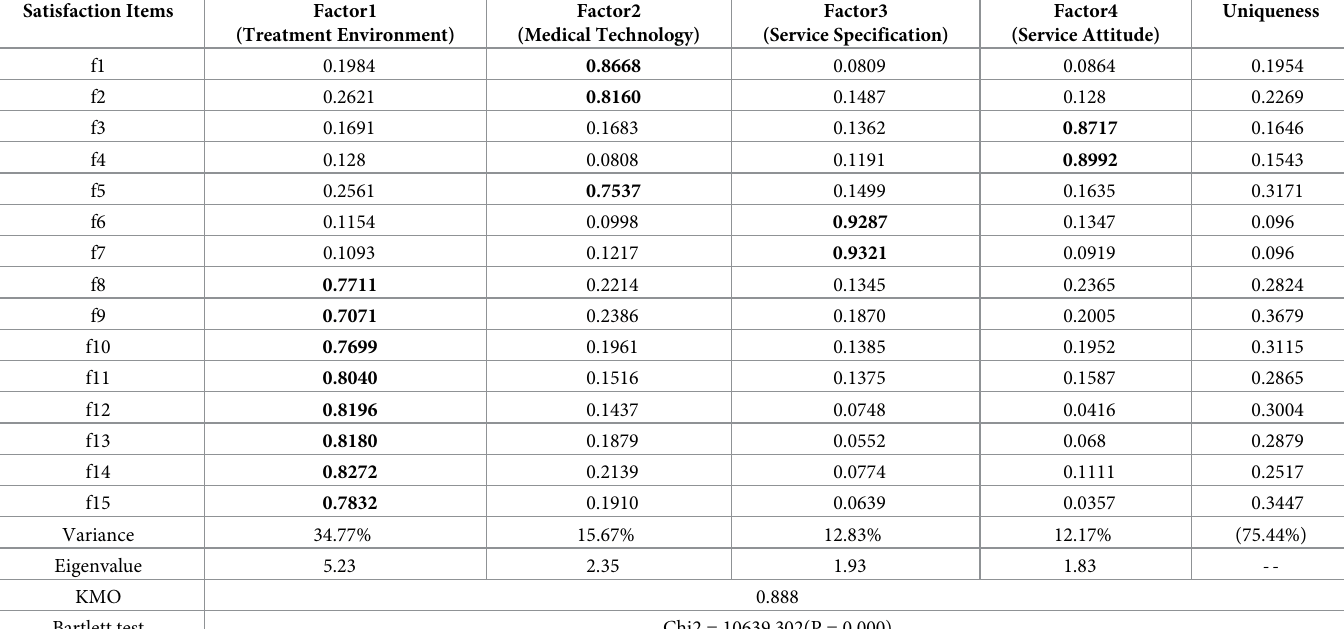
Table 3. Exploratory factor analysis results for satisfaction